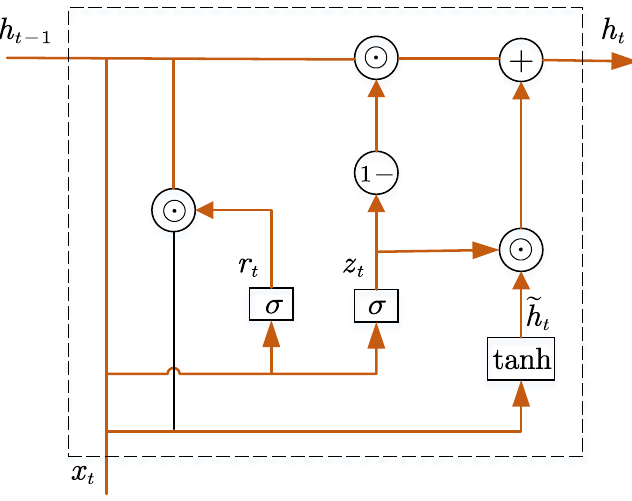
Figure 5. GRU structure diagram.